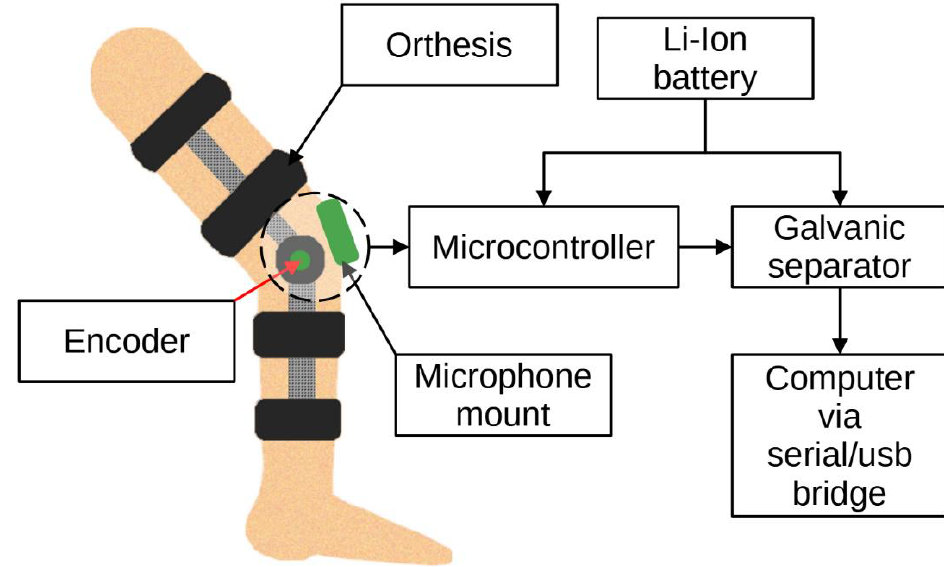
Figure 4. Idea of the measurement system. Examples of normalized signals for healthy and injured knees in the time and fre- quency domain for OKC and CKC recorded with a sensor placed on the patella are shown in Figure 5.